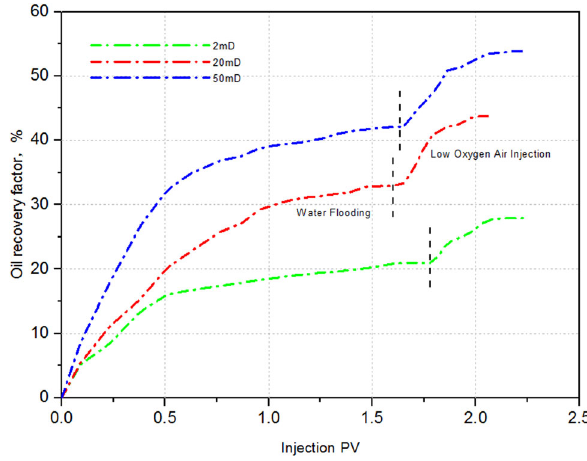
Fig. 5 Oil recovery factor for long cores with different